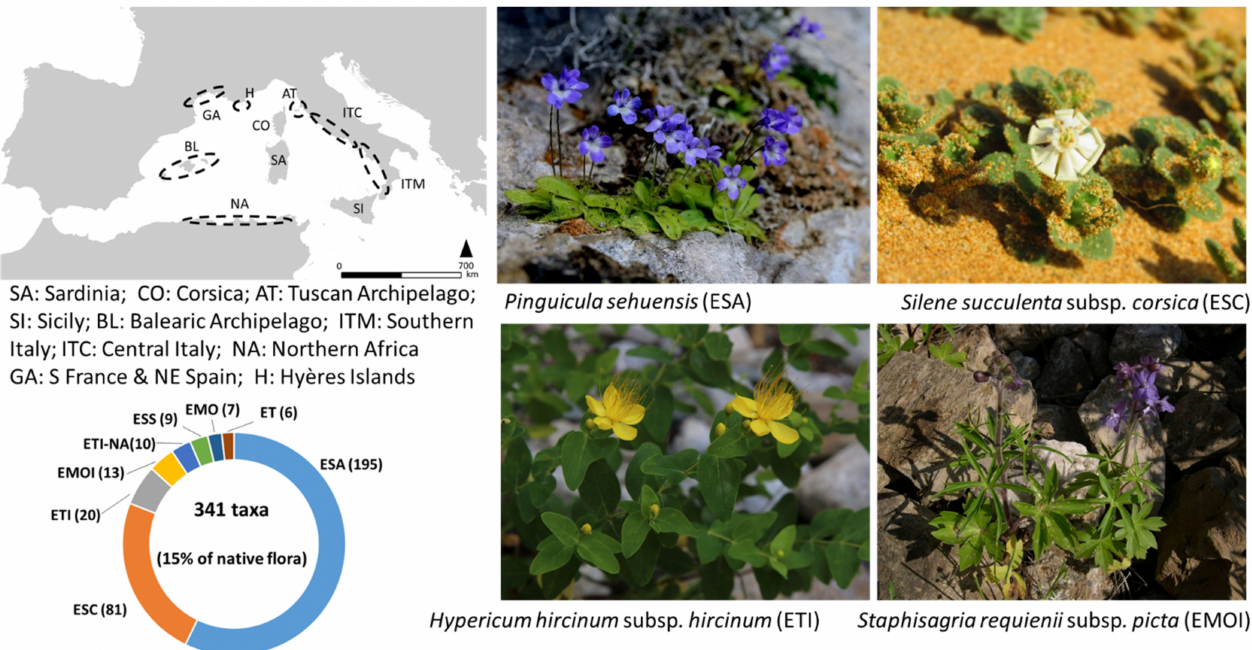
Figure 1. Chorological spectrum of the Sardinian endemic flora. On the right, taxa representative of the four main chorological categories: ESA (SA), ESC (SA + CO), ETI (SA ± CO + AT and/or SI), EMOI (SA ± CO ± AT + BL and/or H), ESS (SA + SI), ETI-NA (ETI + NA), ET (SA + ITM or ITC), EMO (SA + CO and/or GA, ITM,